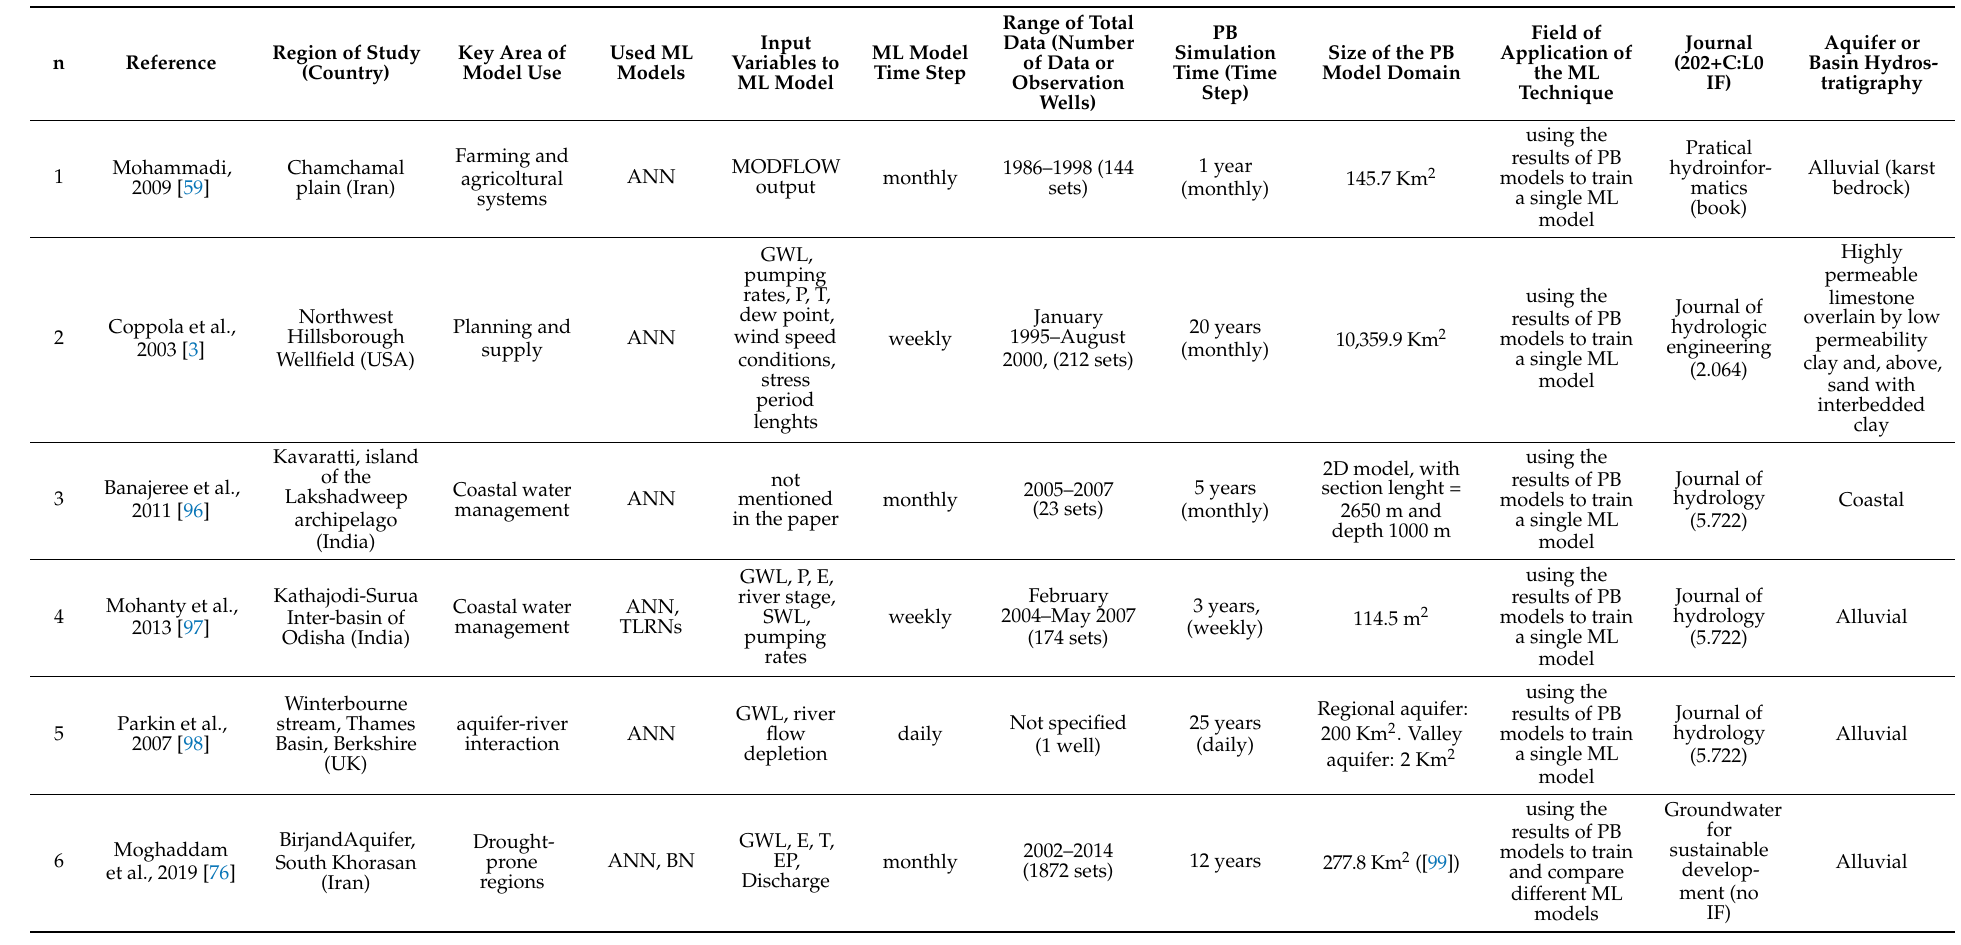
Table 1. List of the reviewed studies. P: precipitation. T: temperature. E: evapotranspiration. SWL: surface water level. EP: effective